Question: Provide a publication-style caption for this figure.
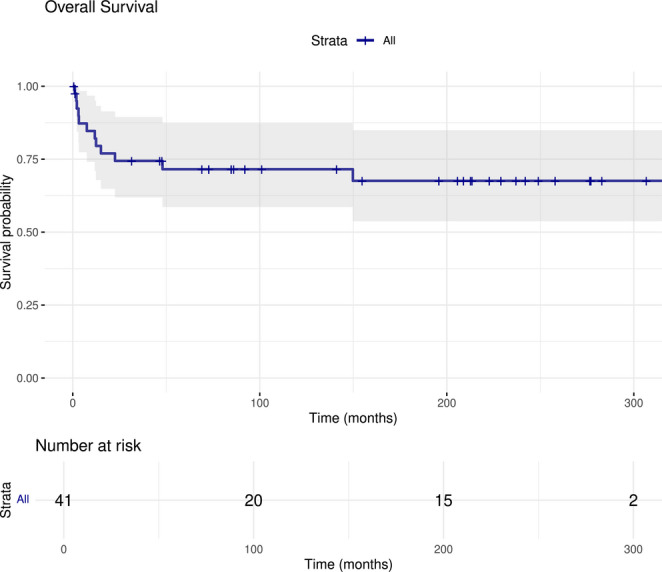
Answer: Kaplan–Meier overall study population (OS)